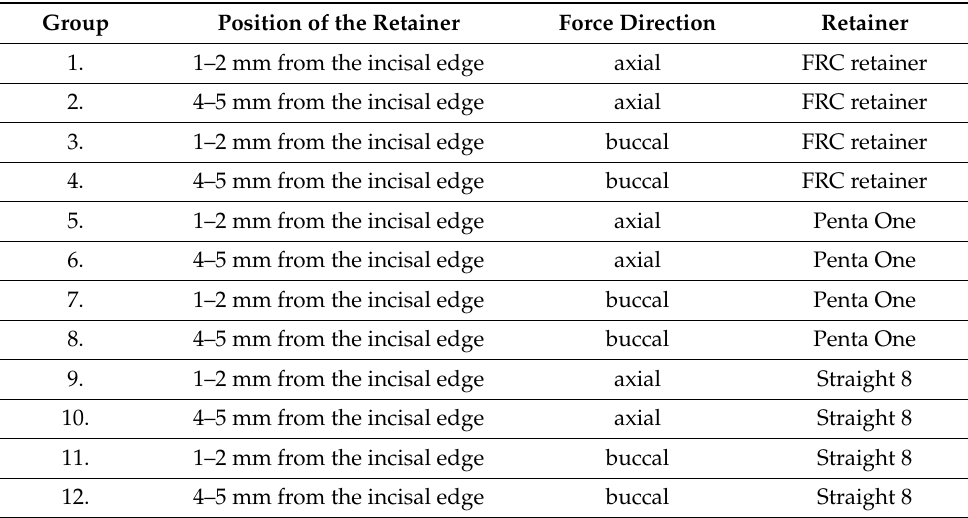
Table 1. Test groups according to the retainer material, direction of the applied load, and position of the retainer, with seven samples in each group.